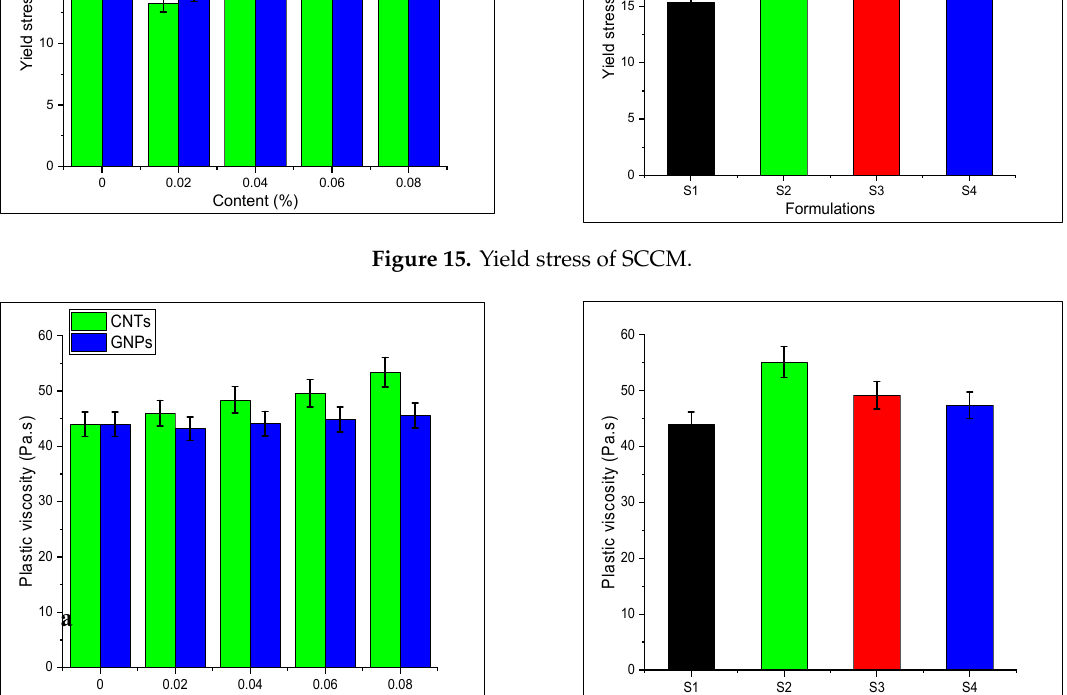
Figure 16. Viscosity of SCCM.